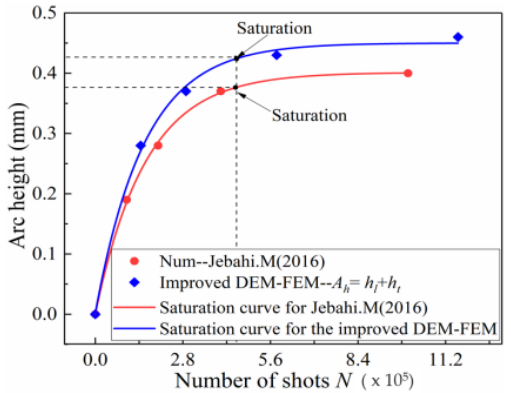
Figure 19. Influence of the transverse deformation on Almen intensity for shot velocity: 50 m / s and S230 steel shot.